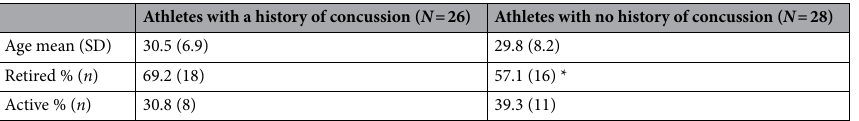
Table 5. Age and athletic status of participants. *One athlete without a history of concussion did not clarify if she was retired or still active (3.6%).